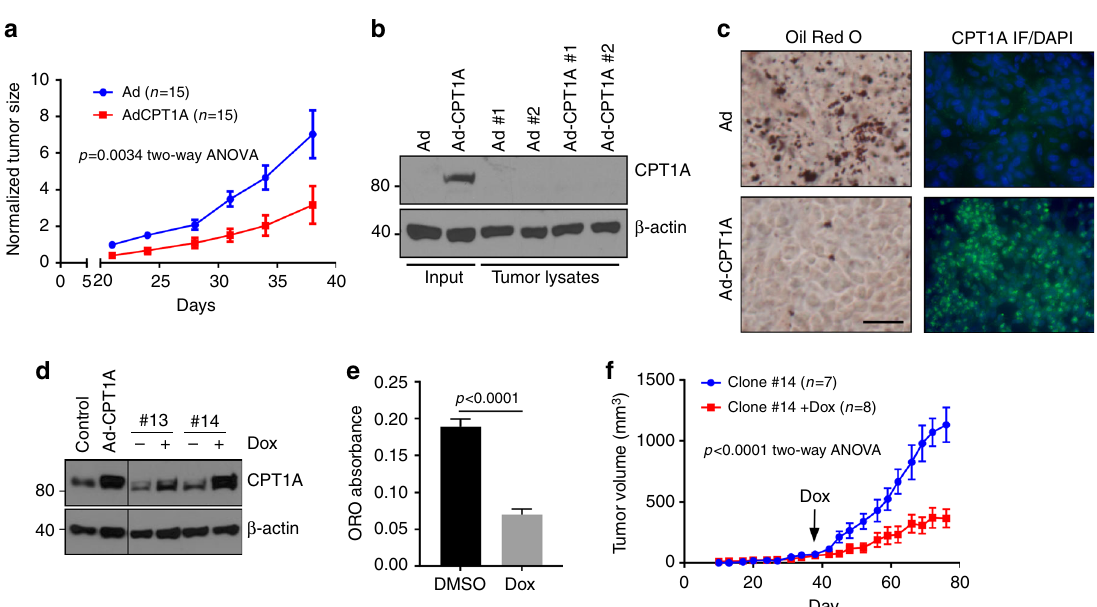
Fig. 7 CPT1A expression limits tumor growth of ccRCC cells in vivo. a Tumor growth measurements of 786-O cells infected with GFP or CPT1A-expressing adenovirus implanted on the fl anks of nude mice. b Western blot of various protein lysates extracted from tumors measured in a stained for CPT1A and β - actin levels. c Photomicrographs of Oil Red O staining and immuno fl uorescent staining of a GFP and CPT1A tumor described in a . Immuno fl uorescence was performed with a FITC-labeled secondary antibody and counterstained with DAPI. Bar = 20 μ m. d Western blot of depicting doxycycline-inducible CPT1A expression in two 786-O clonal cell lines compared to adenoviral-infected control cell lines. Blots were probed for CPT1A and β -actin. e Quanti fi cation of Oil Red O staining of clone #14 treated with or without doxycycline. f Tumor growth measurements of clone #14 implanted subcutaneously into the fl anks of nude mice. Doxycycline food was given to the Dox cohort when average tumor volumes reached ~100 mm 3 through to the end of the assay. Error bars represent standard deviations. p values for two-way ANOVAs for a , f , and a two-tailed Student ’ s t test ( e ) are